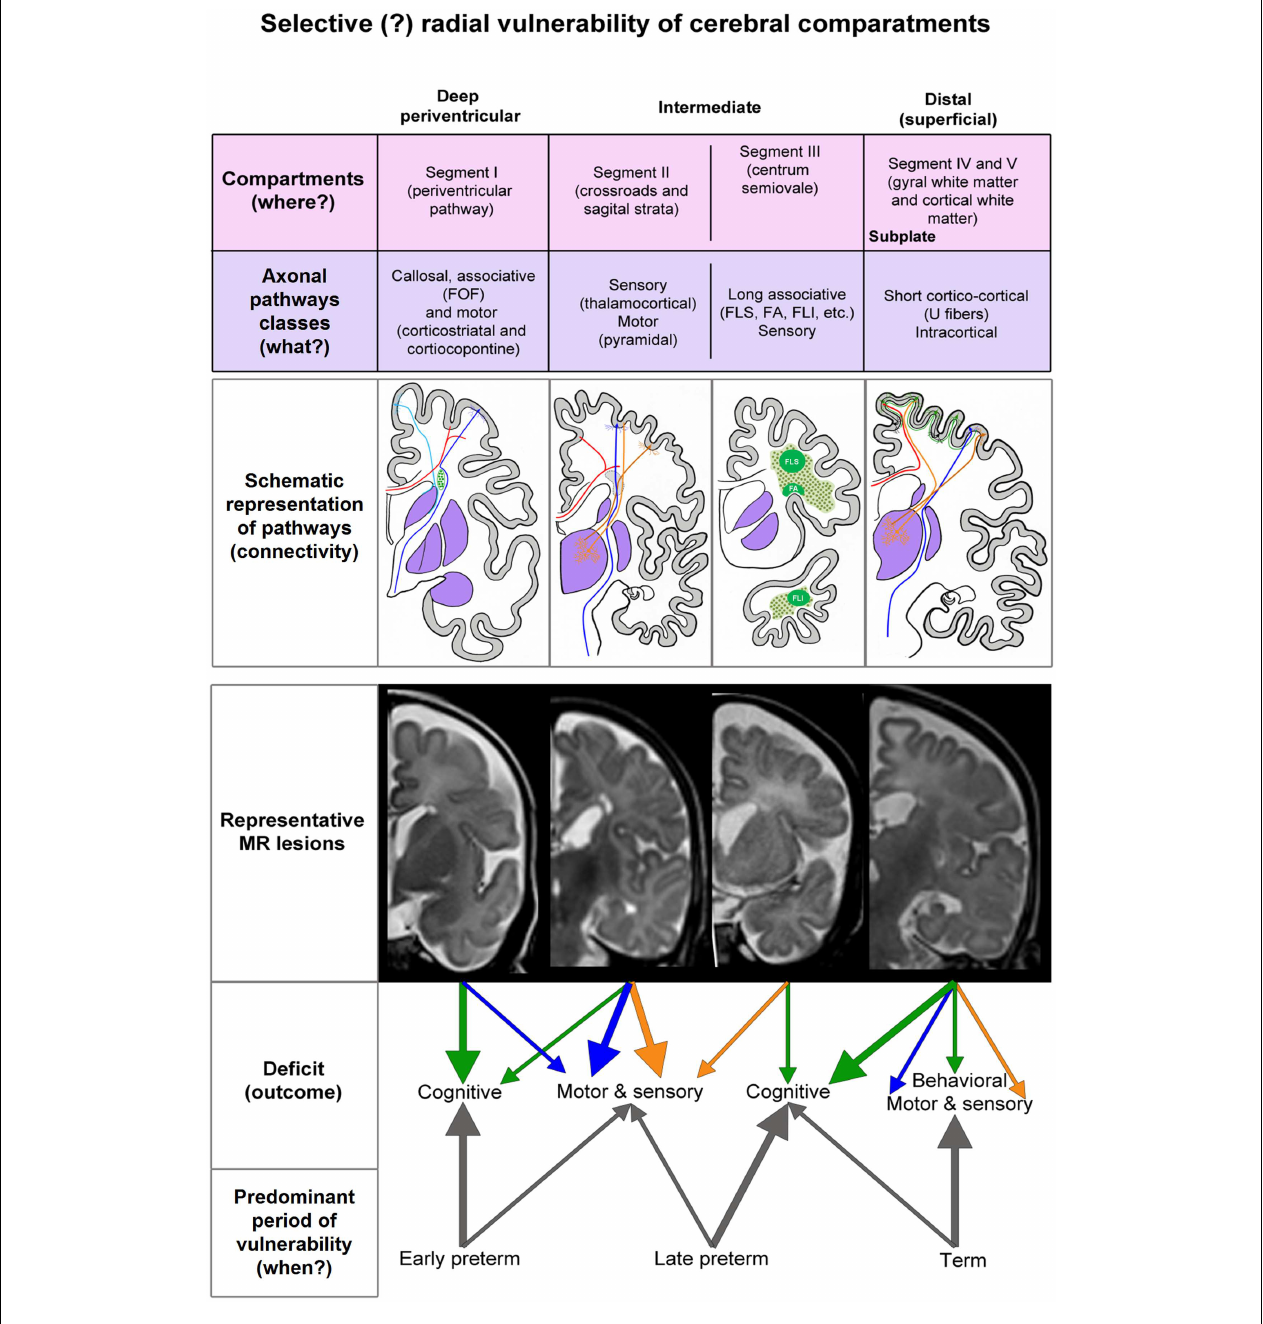
selected from clinical cases other then presented in Figures 1 – 5 .The proposed deficit (arrows) is derived from the prospective function of lesioned classes of axonal pathways. FOF, fronto-occipital fascicle; FLS, longitudinal superior fascicle; FA, arcuate fascicle; FLI, longitudinal inferior